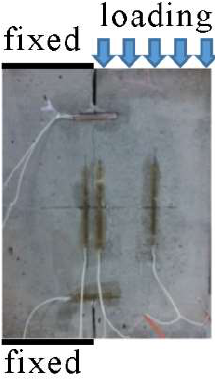
Figure 3. Specimen for DNSCT of mode ΙΙ shearing [49].